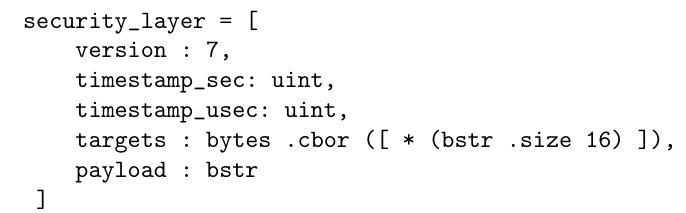
Figure 2. Concise Data Definition Language (CDDL) specification of the xAAL Security Layer.